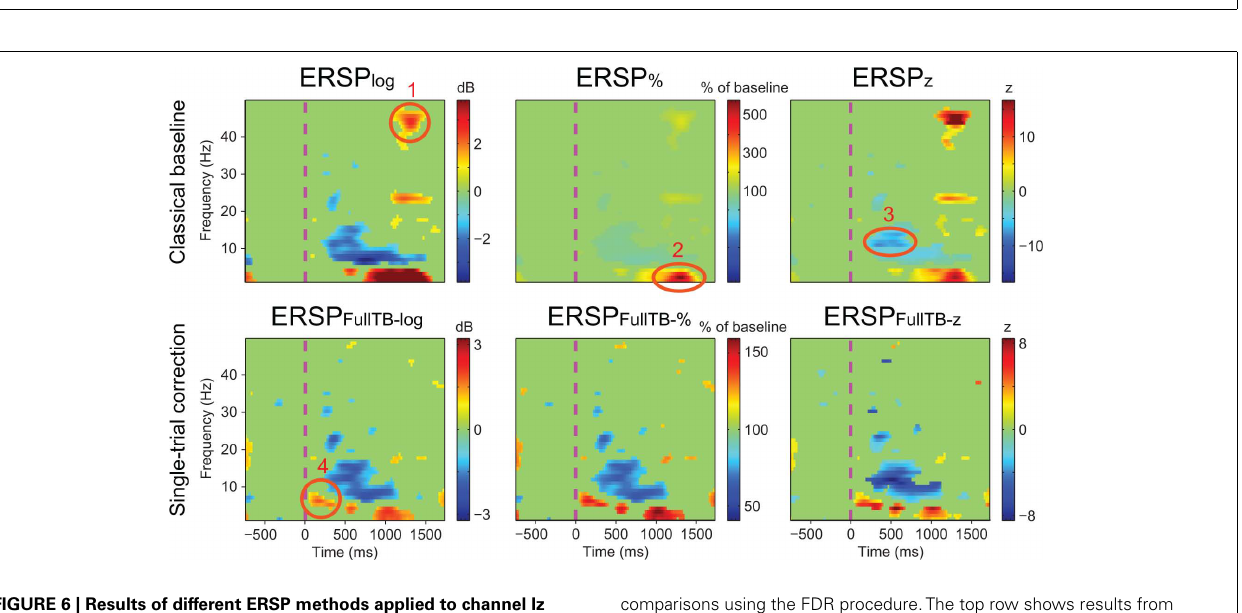
FIGURE 5 | Confusion matrix of the ERSP classical method and the ERSP using single-trial correction for different amplitude of noise. The single-trial-based method (ERSP FullTB − log ) clearly